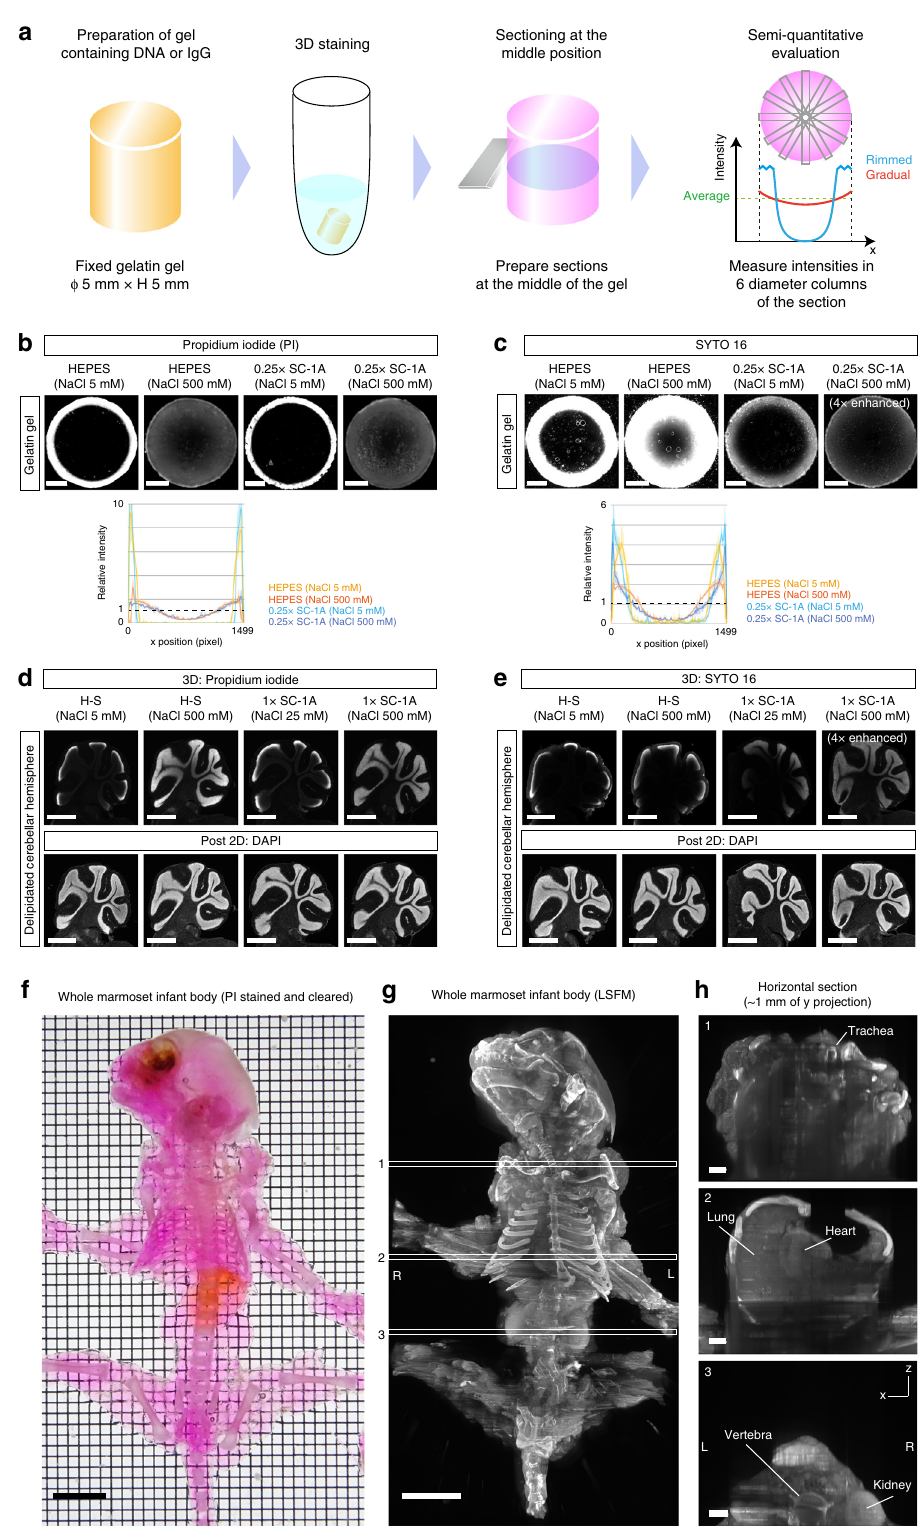
ionized but more lipophilic dye, SYTO 16, the rimmed pattern was still observed for HEPES buffer containing 500 mM NaCl (Fig. 2c). Therefore, given our previous success in 3D staining using SYTO 16 with Sca l eCUBIC-1 13 , we tested a Sca l eCUBIC-1- based staining buffer. When supplied with 500 mM NaCl, the reagent indeed changed the SYTO 16 staining result from